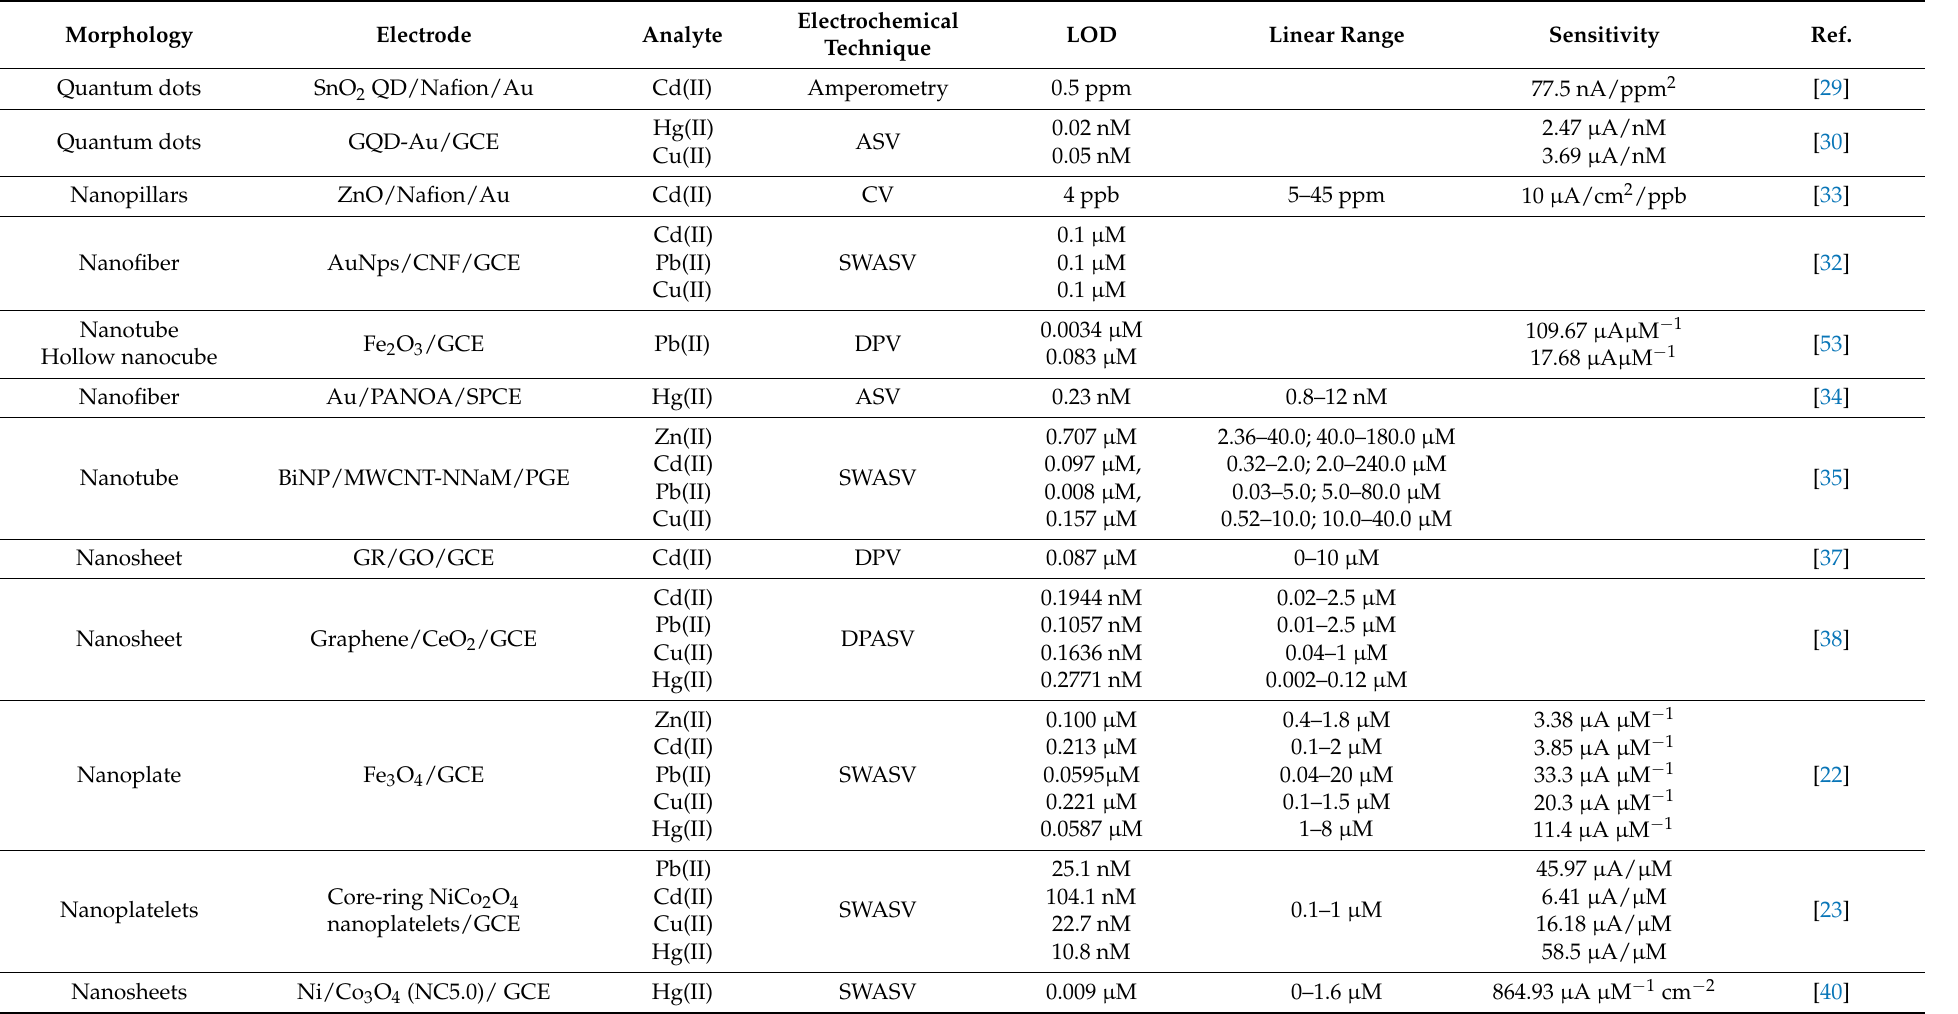
Table 2. Improvement of analytical figures of merit with morphology of electrocatalyst based